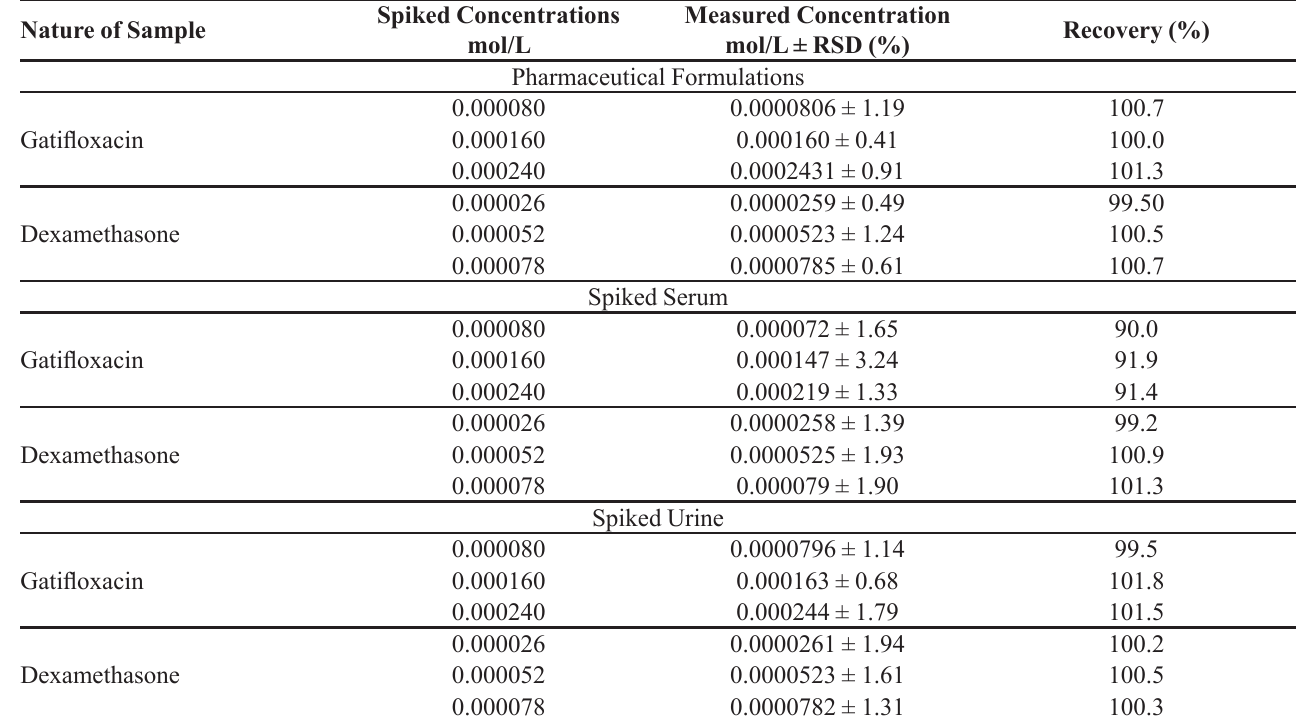
TABLE I - Accuracy of the proposed HPLC method